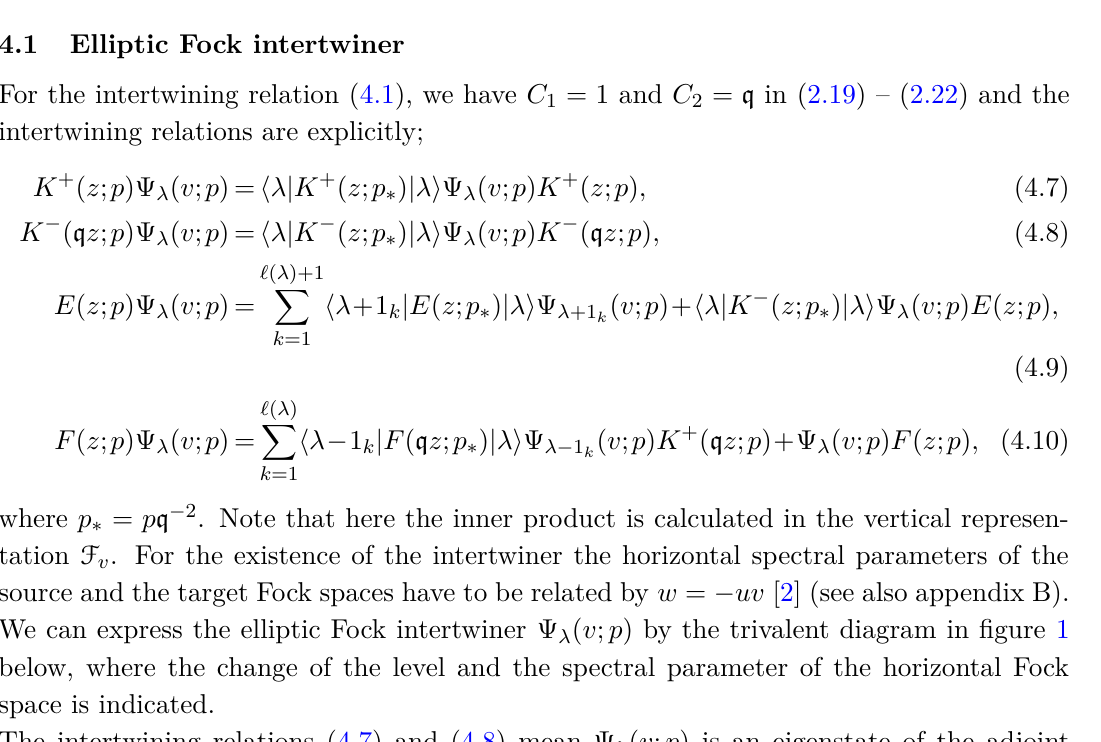
Figure 1 . Trivalent diagram of the elliptic Fock intertwiner Ψ λ ( v ; p )